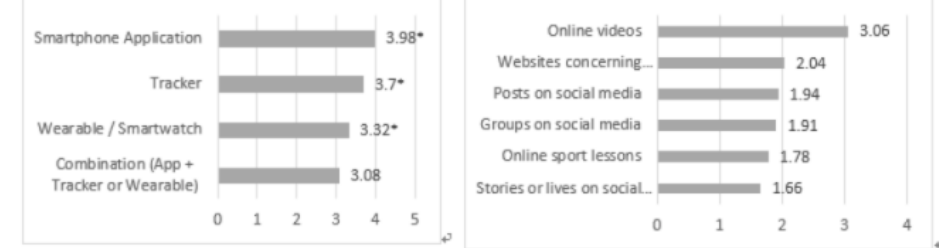
Figure 7. Mean scores of the intended future use of digital support (5-point Likert Scale). * = significantly higher score than the neutral value of three.